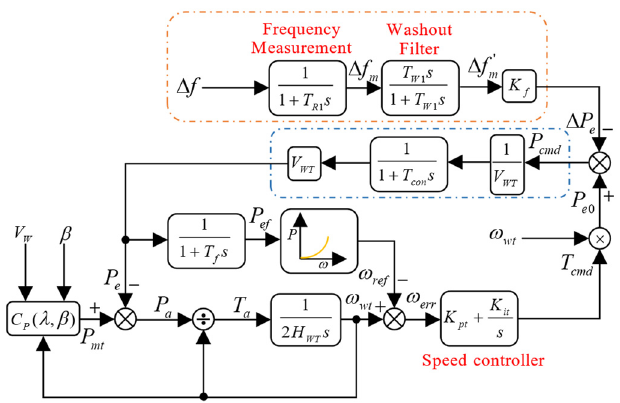
Figure 1. Two-area interconnected power system.